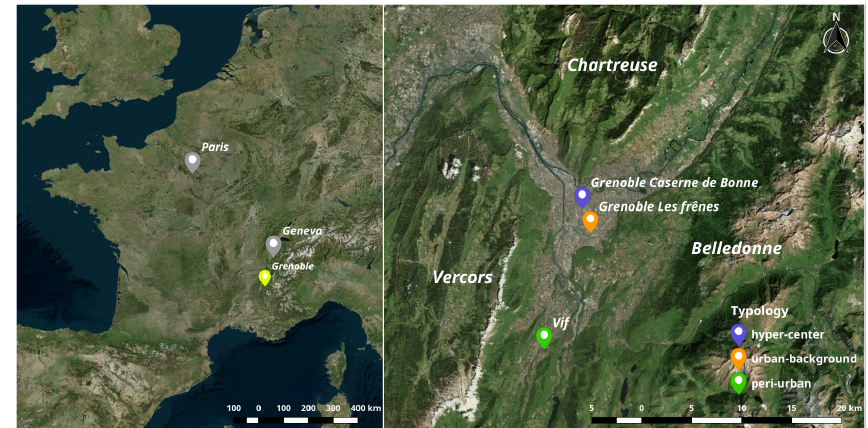
Figure 1. Grenoble, the city where the sampling was made, placed on a European map (left), and PM monitoring sites (right): Les Frênes or LF (background), Caserne de Bonne or CB (hyper-center), and Vif (peri-urban). Image credit: Bing™Aerial. ©